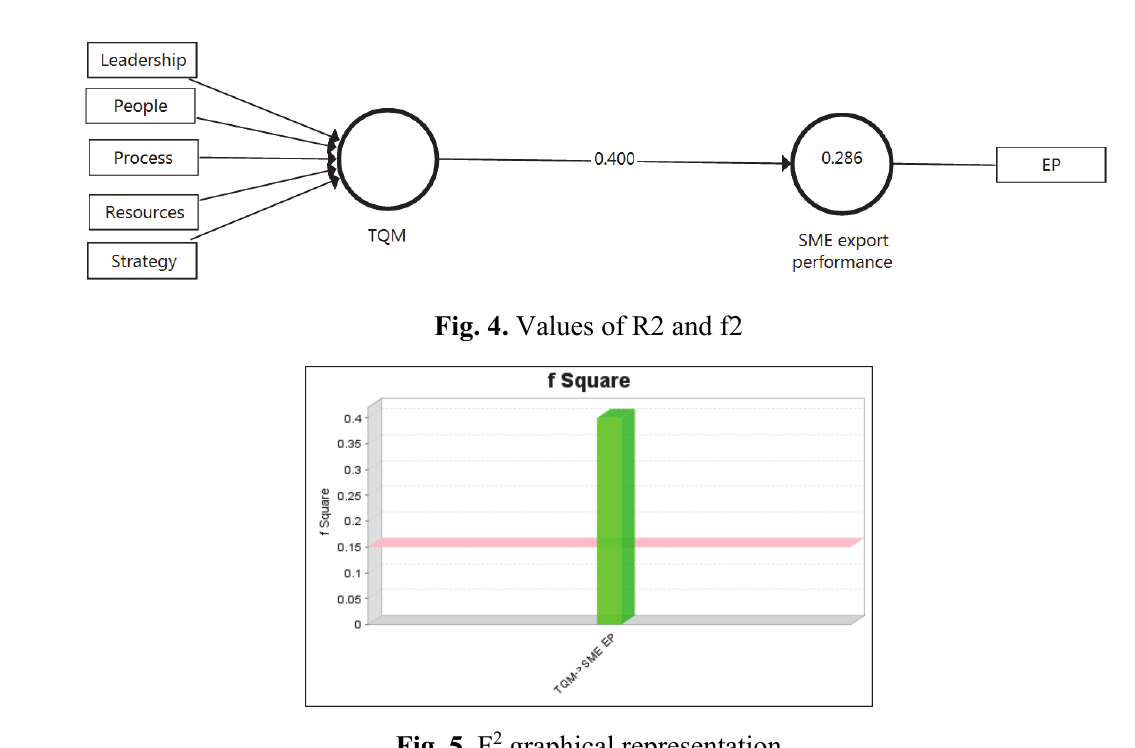
Fig. 5. F 2 graphical representation